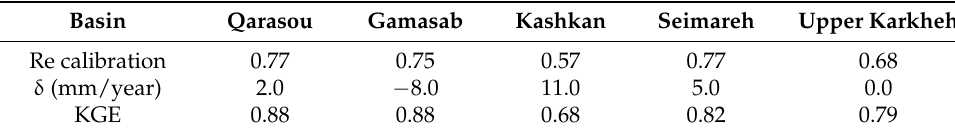
Table 5. Calibration performance indices for the studied